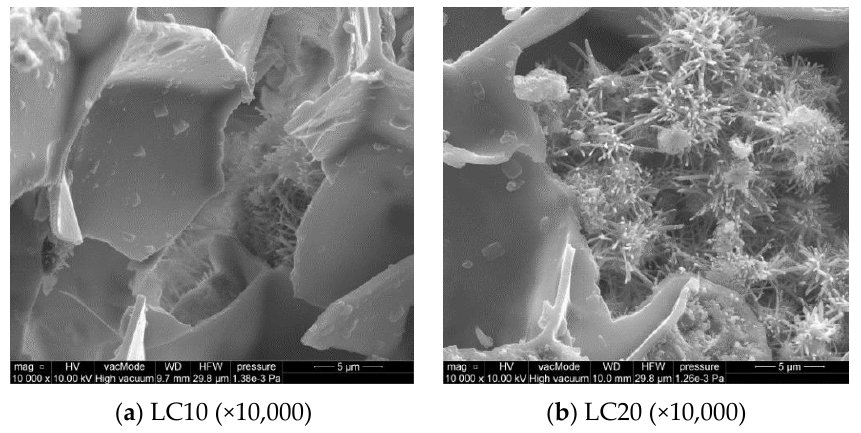
Figure 8. SEM microstructure of LC10 and LC20 concrete—EPS walls, fibrous structure of C–S–H phase and ettringite crystals at 10,000 times magnification. ( a ) LC10 ( × 10,000); ( b ) LC20 ( × 10,000).